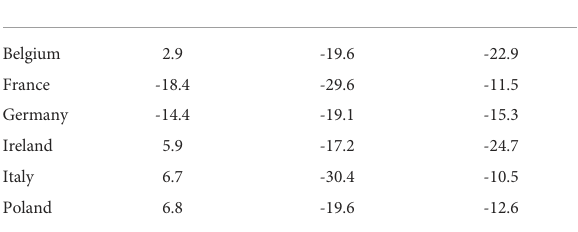
TABLE 2 Relative differences in serum Cu, Se and Zn with respect to